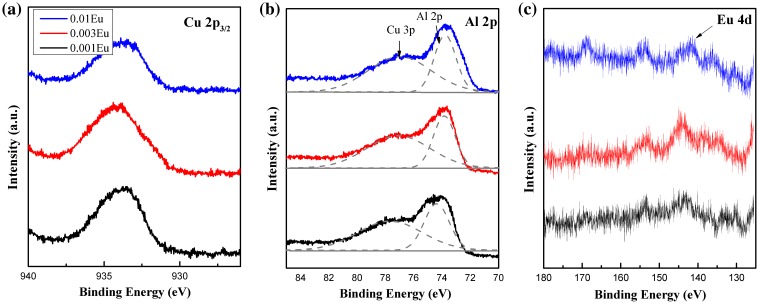
XPS spectra of (a) Cu 2p3/2, (b) Al 2p, and (c) Eu 4d levels.